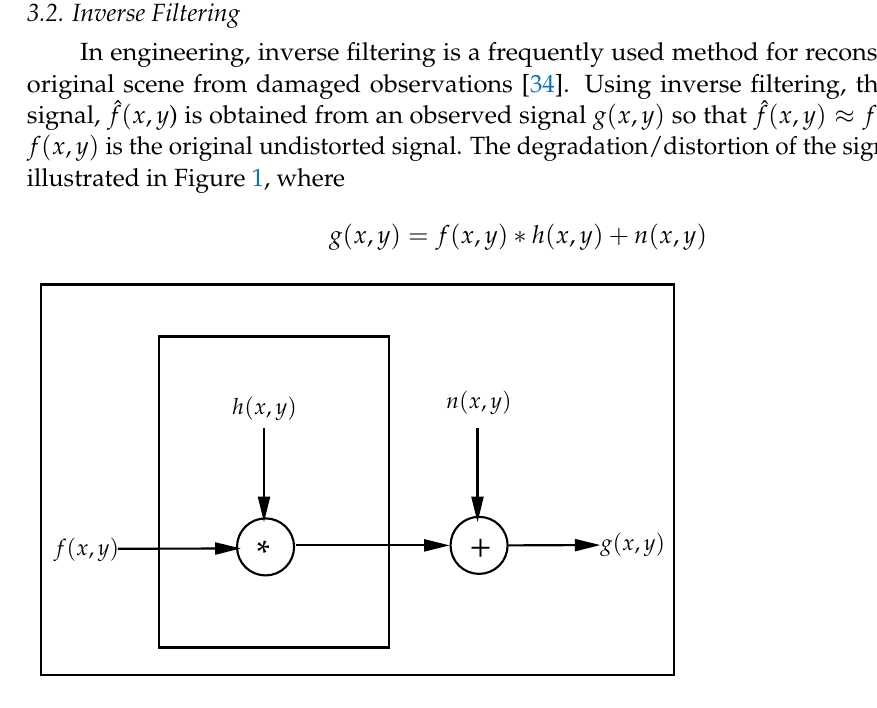
Figure 1. Modeling the distortion/degradation of a